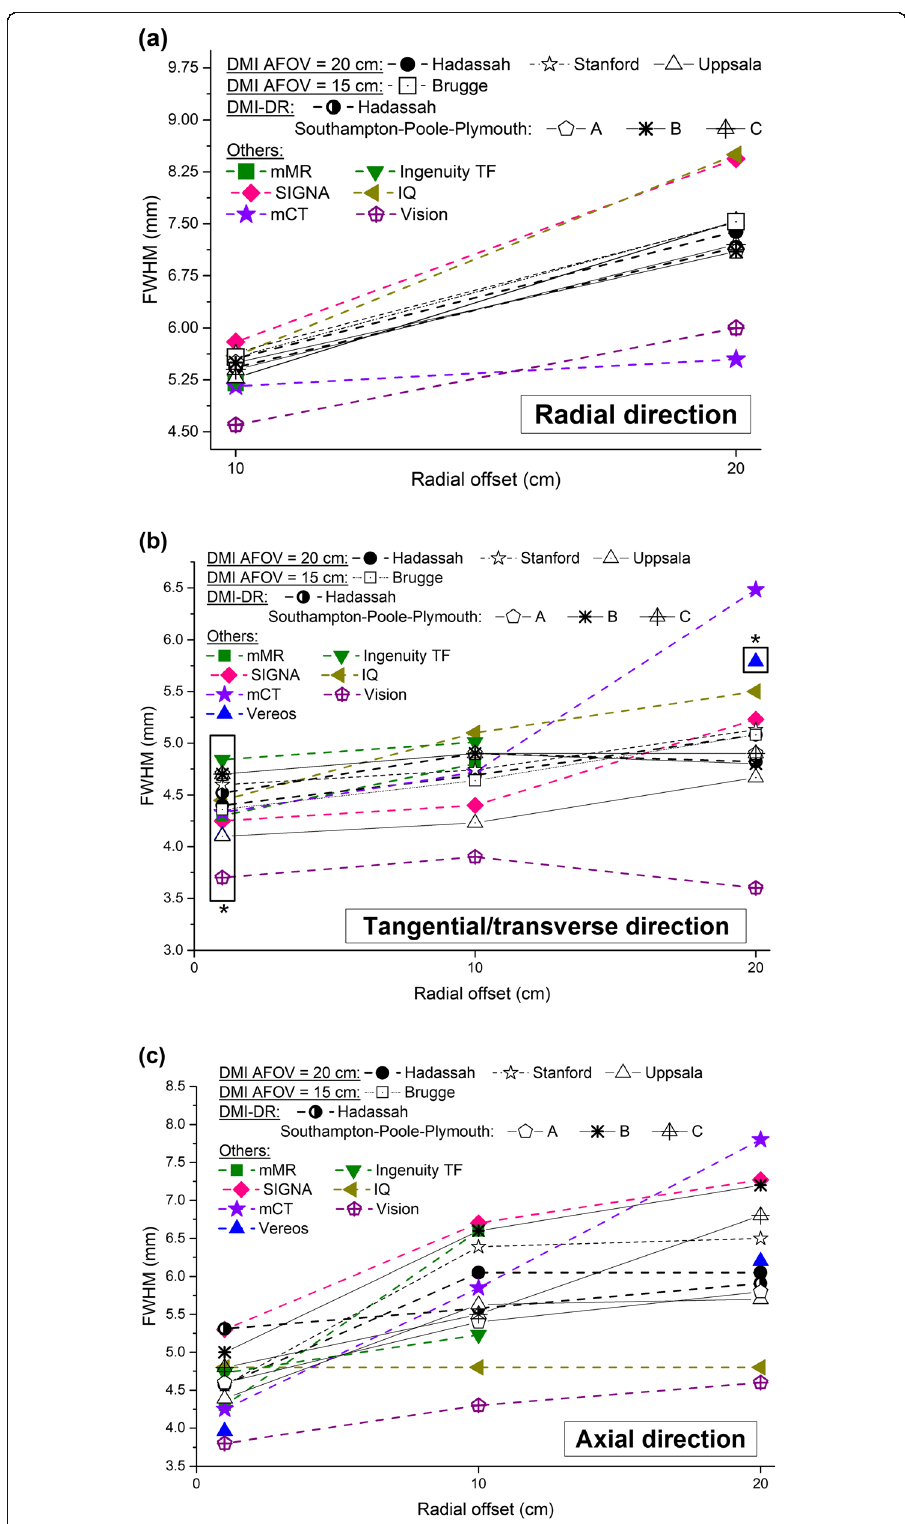
Fig. 6 (See legend on next